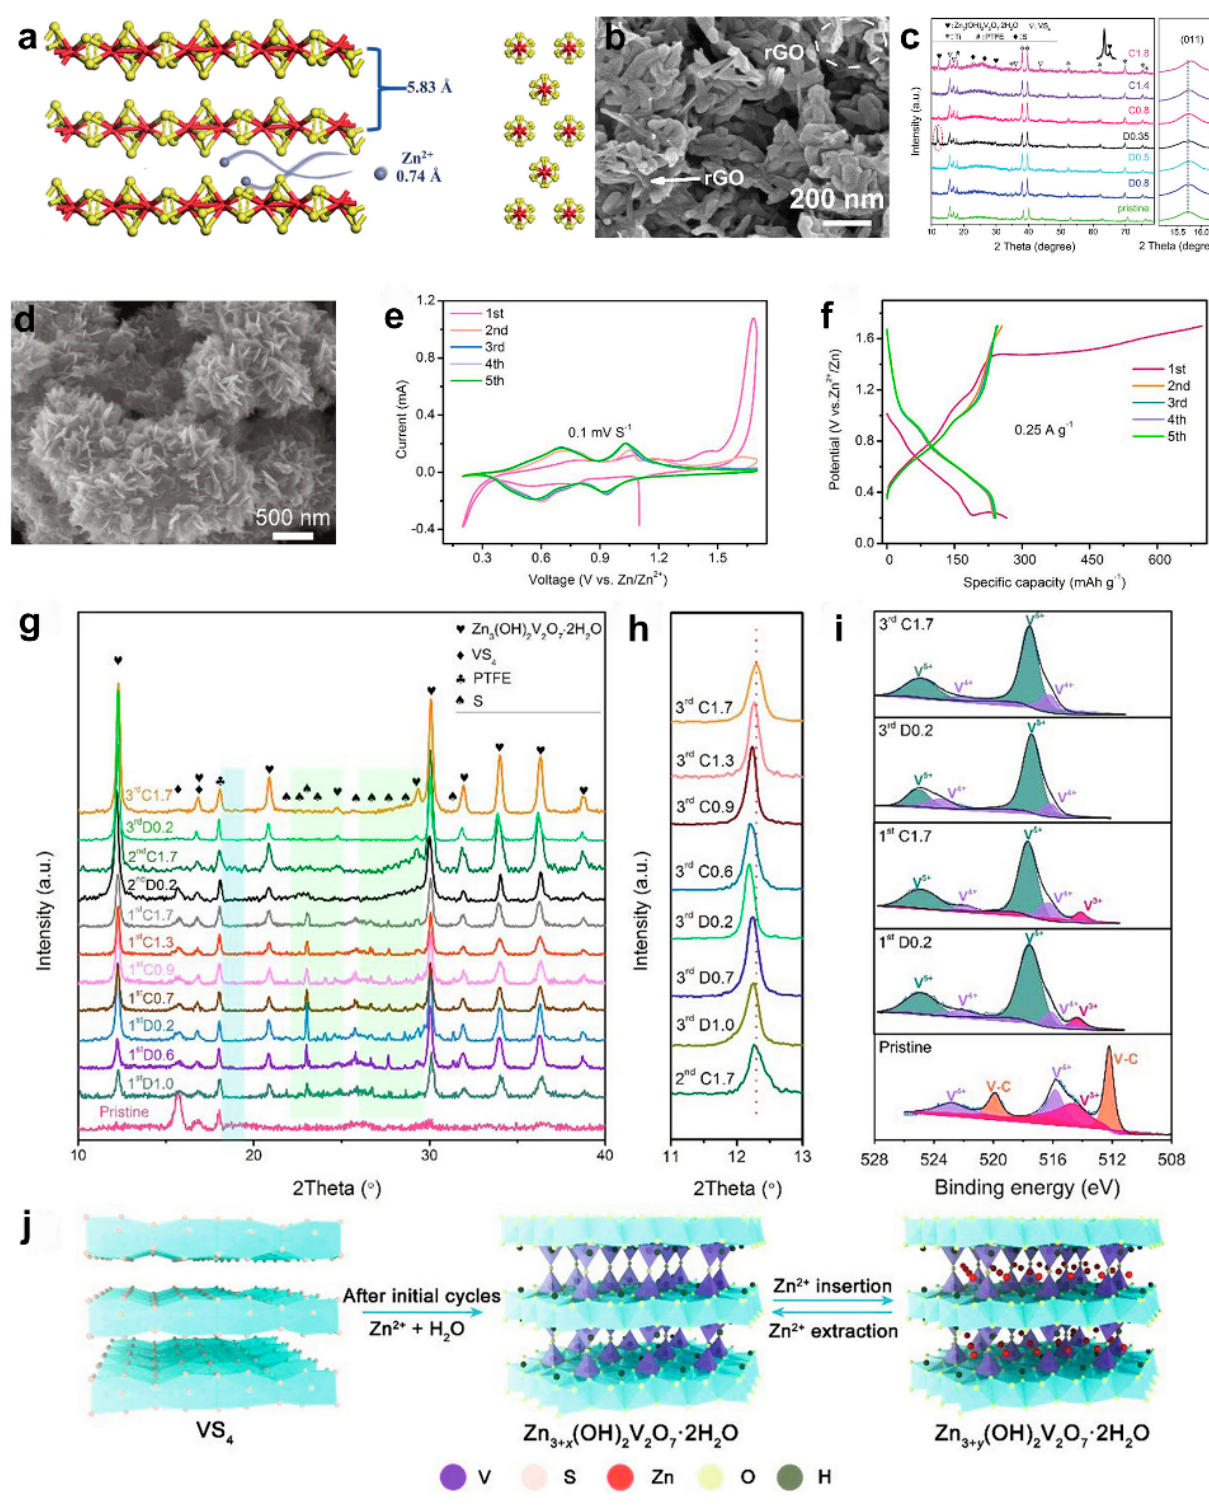
Figure 5. ( a ) Schematic diagram of the VS 4 [58]. ( b ) The SEM image of VS 4 @rGO [63]. ( c ) Ex situ XRD patterns of VS 4 @rGO in the first charge/discharge cycle [63]. ( d ) The SEM images of VS 4 /CNTs. ( e ) CV curves of VS 4 /CNTs electrode at a scan rate of 0.1 mV · s − 1 [66]. ( f ) Discharge–charge profiles of VS 4 /CNTs electrode at 0.25 A · g − 1 [66]. Ex situ ( g ) XRD patterns of VS 4 /CNTs, ( h ) enlarged area of ZVO (001) planes, and ( i ) V 2p XPS spectra of VS 4 /CNT [66]. ( j ) Schematic representation of the reaction mechanism of the VS 4 /CNT cathode during cycling